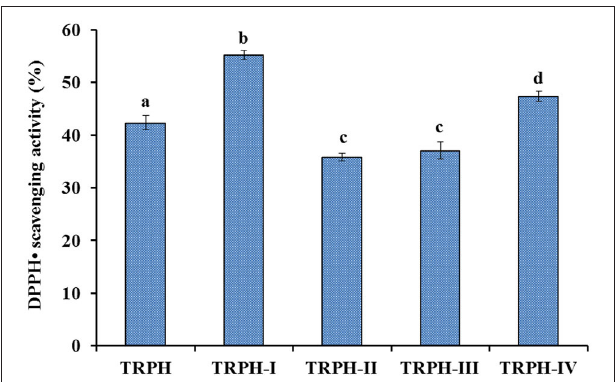
FIGURE 2 | DPPH • scavenging activity (%) of TRPH and its four fractions (TRPH-I to TRPH-IV). All values are means ± SD ( n = 3). a − d Values with same letters indicate no significant difference ( p >